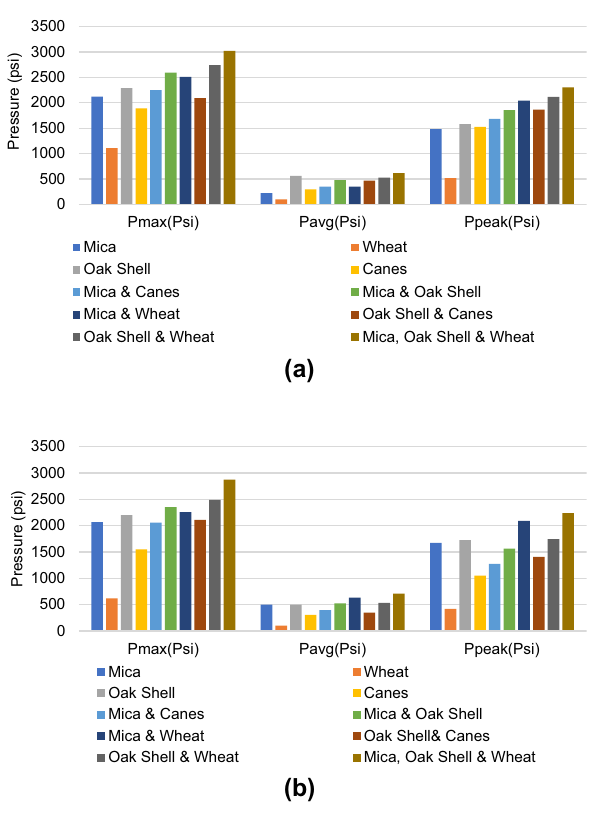
Fig. 34 Pressure parameters with 1000 & 3000 micron cells and all